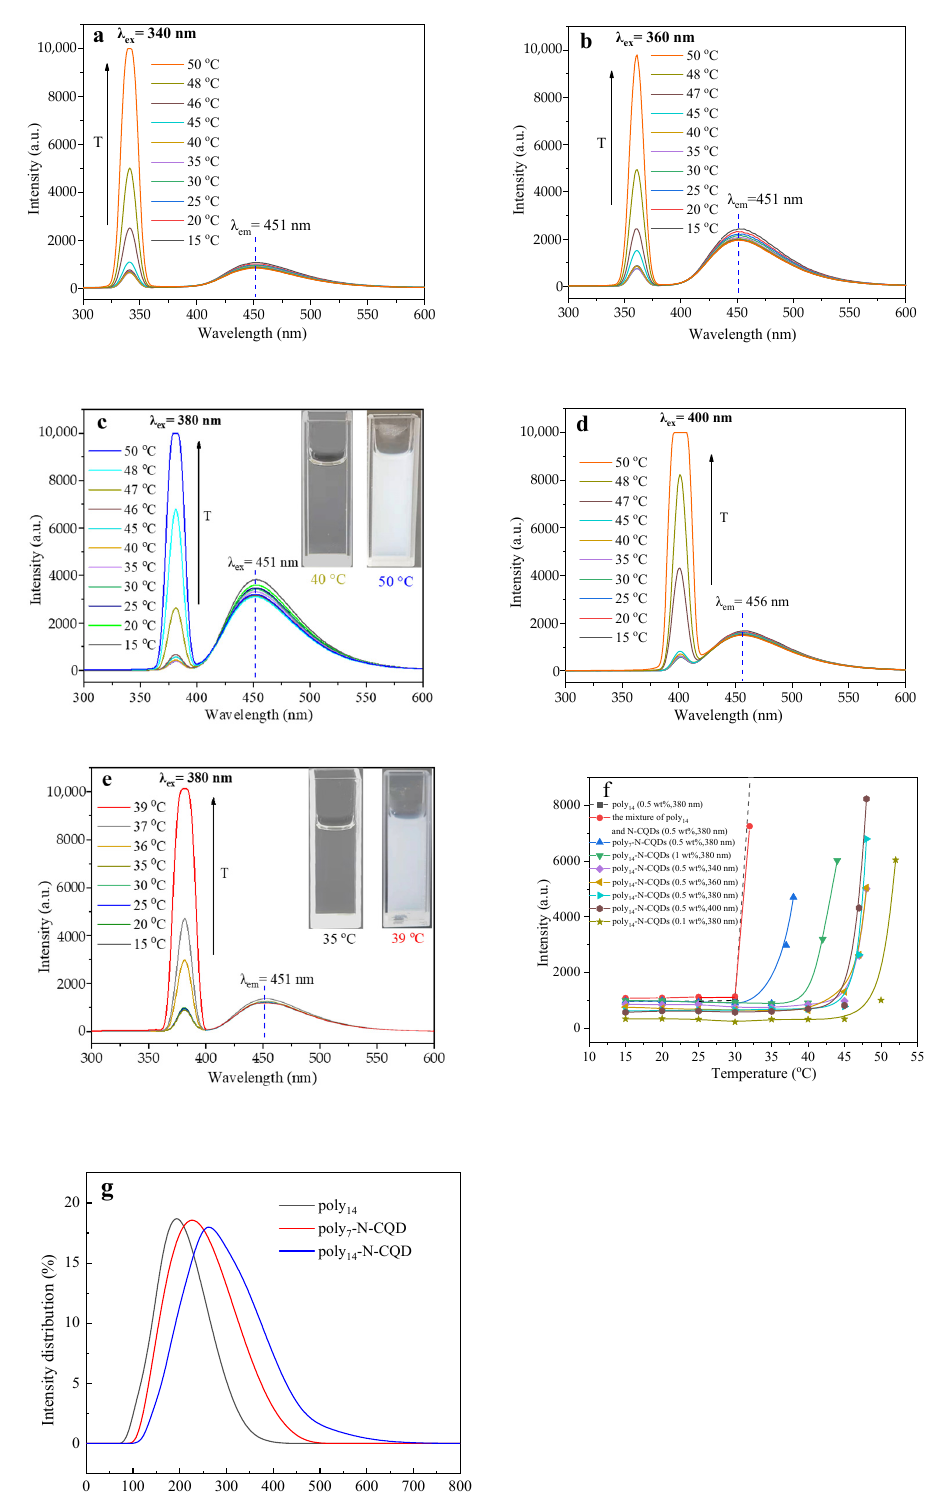
Figure 3. The fluorescence emission spectra of the poly 14 -N-CQDs at different excitation wavelengths (340 nm ( a ), 360 nm ( b ), 380 nm ( c ) and 400 nm ( d )), and the poly 7 -N-CQDs at 380-nm excitation wavelength at different temperatures ( e ); plot of the scattering peak intensity as a function of the temperature ( f ), and the size distribution of dilute aqueous solutions of poly 14 , poly 7 -N-CQDs and poly 14 -N-CQDs at 32 °C, 40 °C and 50 °C, respectively ( g ).